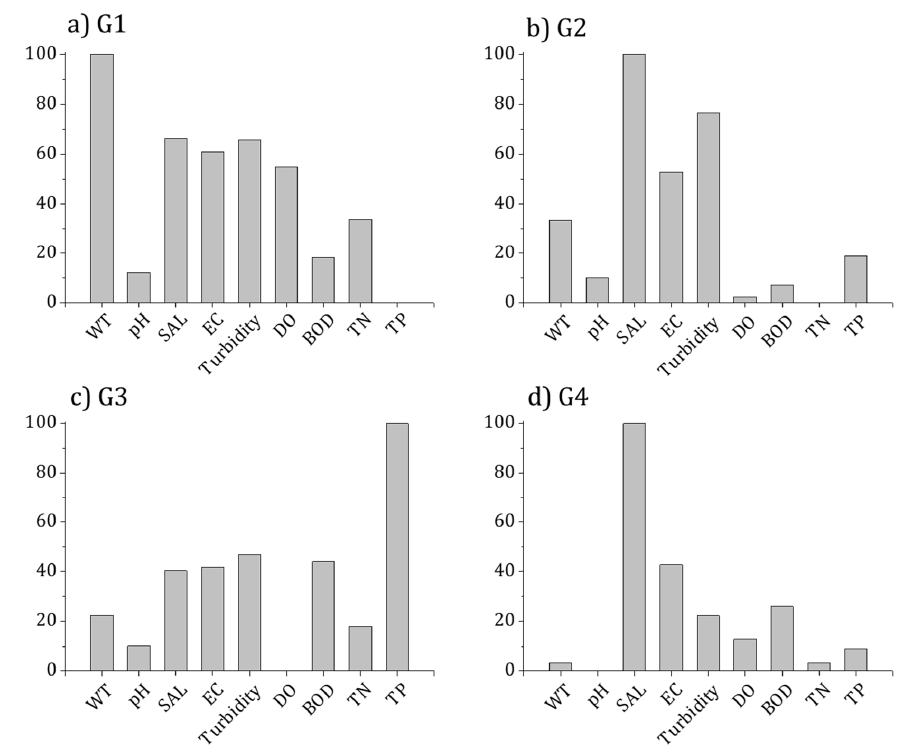
Figure 6. Relative importance (%) of predictable variables using a random forest model in four diatom communities defined by cluster analysis based on diatom abundance in Korean estuaries between 2009 and 2016: ( a ) G1; ( b ) G2; ( c ) G3; and ( d ) G4. WT, water temperature; SAL, salinity; EC, electric conductivity; DO, dissolved oxygen; BOD, biochemical oxygen demand; TN, total nitrogen; TP, total phosphorus.